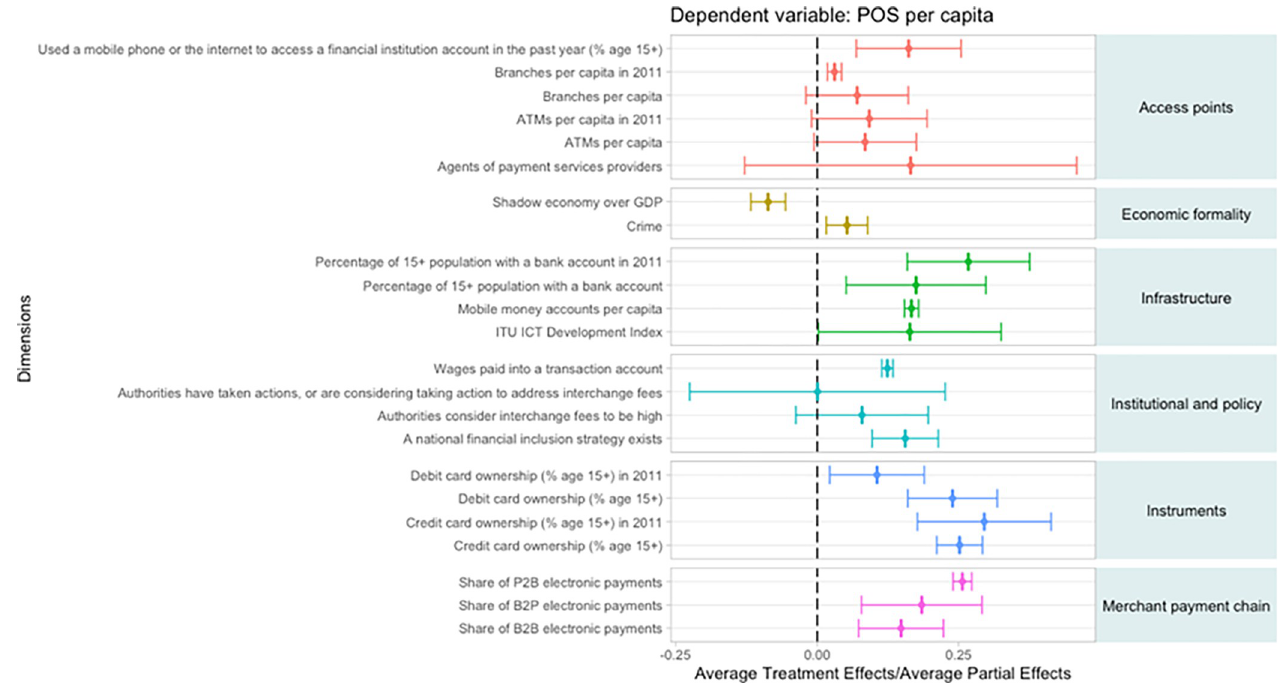
Fig 2. Treatment effects on POS adoption (country-level